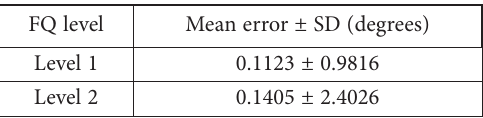
Table 11. Performance scores for lateral tracking task